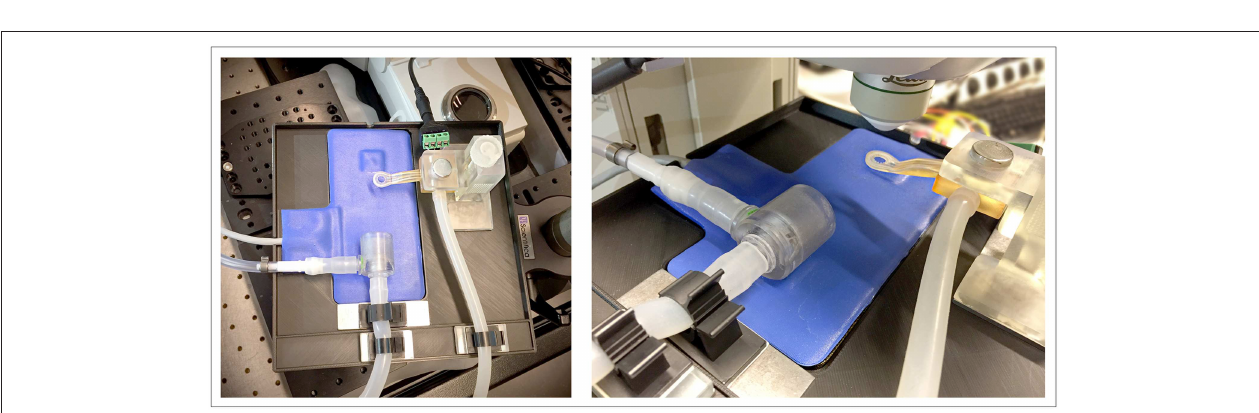
FIGURE 5 | Complete setup of the 3D-printed in vivo imaging platform mounted on a Scientifica stage on the Leica SP8 confocal microscope, shown together with heating pad, anesthetic mask and metal plate mounted holders for tubing.